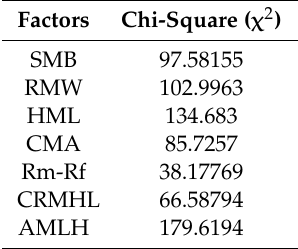
Table A1. Chi-square test of industry in di ff erent factors.